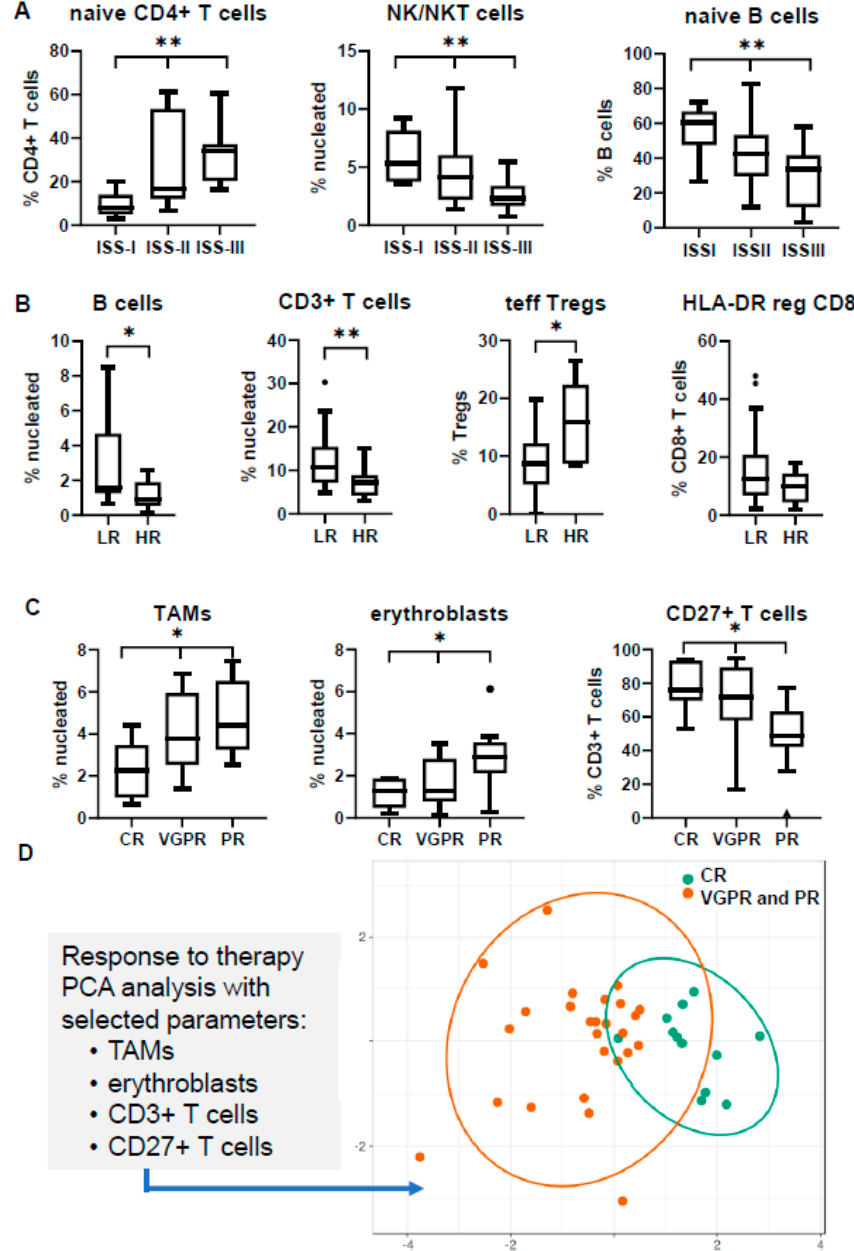
Figure 3. Distribution of bone marrow (BM) subsets in different clinical and prognostic groups at the time of diagnosis. Comparisons refer to ( A ) the International Staging System (ISS); ( B ) cytogenetics; ( C ) response to therapy; ( D ) PCA analysis of selected BM subsets according to therapeutic response. * p < 0.05, ** p < 0.01; HR: high-risk; LR: low-risk; CR: complete response; VGPR: very good partial response; PR: partial response; TAMs: tumor-associated macrophages; PCA: